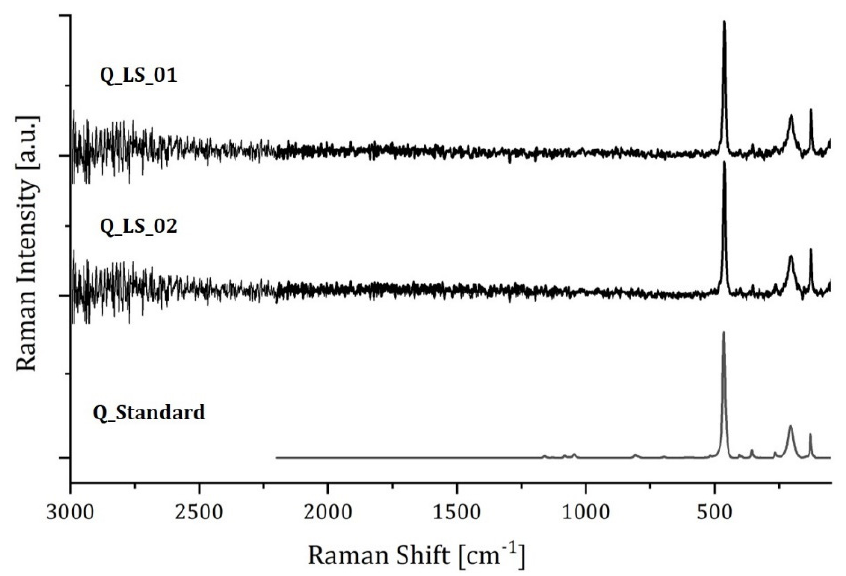
Figure 5. Raman spectra recorded in different points of La Sassa quartz (Q_LS_01-02) compared with a quartz reference Raman spectrum (OMNIC Picta™ reference spectral library).